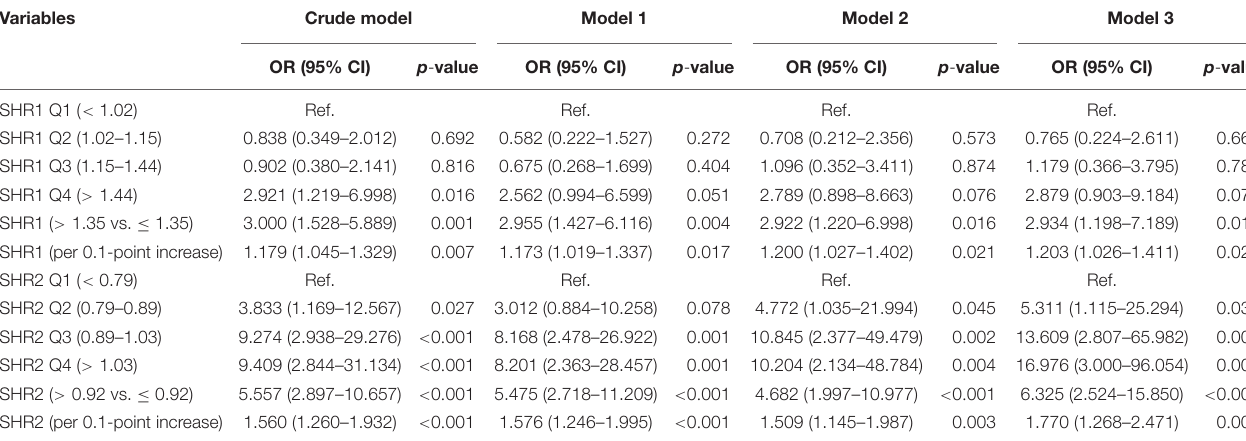
TABLE 3 | Univariate and multivariate logistic regression analysis for 3-month poor functional outcome in sensitivity